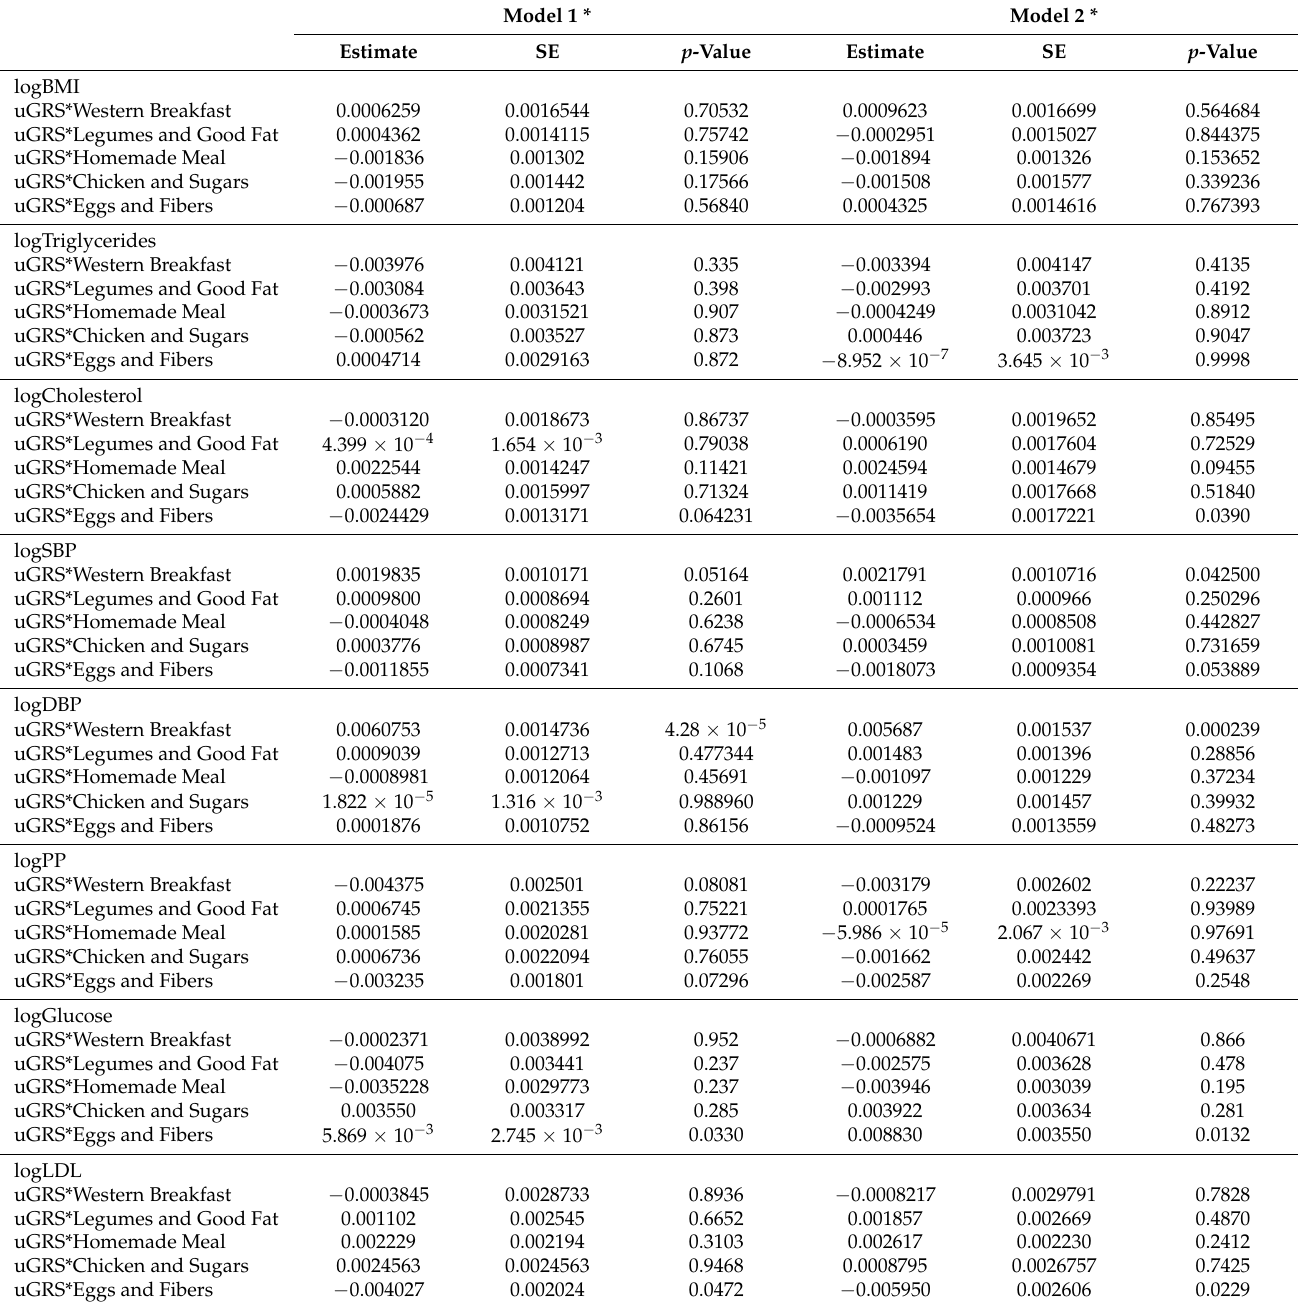
Table 5. Associations between the 9-SNP uGRS for VEGF-A and dietary patterns in the TEENAGE cohort. Model 1 * Model 2